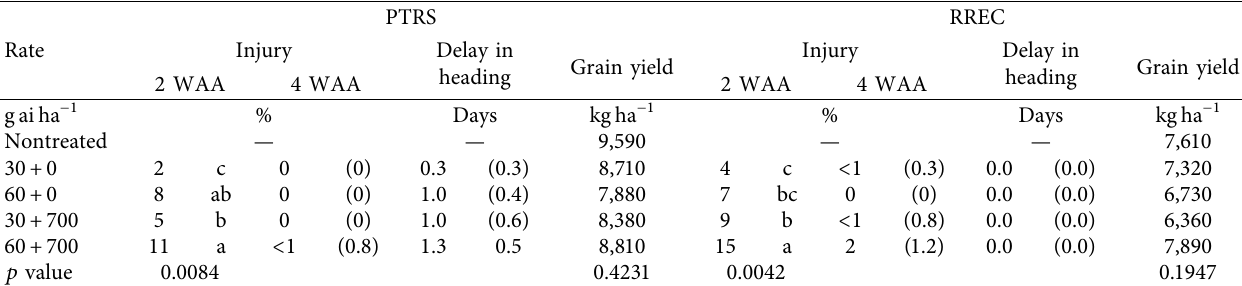
Table 9: Injury 2 and 4 weeks after application (WAA), heading delay, and grain yield response of CL272 to different rates of florpyrauxifen- benzyl and malathion applied preflood a,b,c